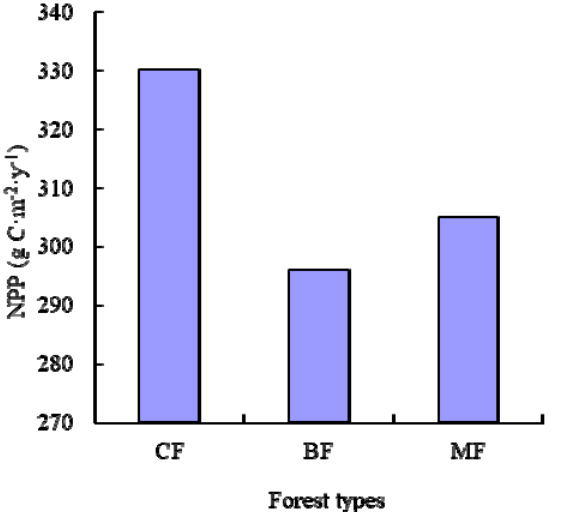
Figure 7. Average NPP for the three main forest type groups in Heilongjiang province, China, from 2001 to 2010.